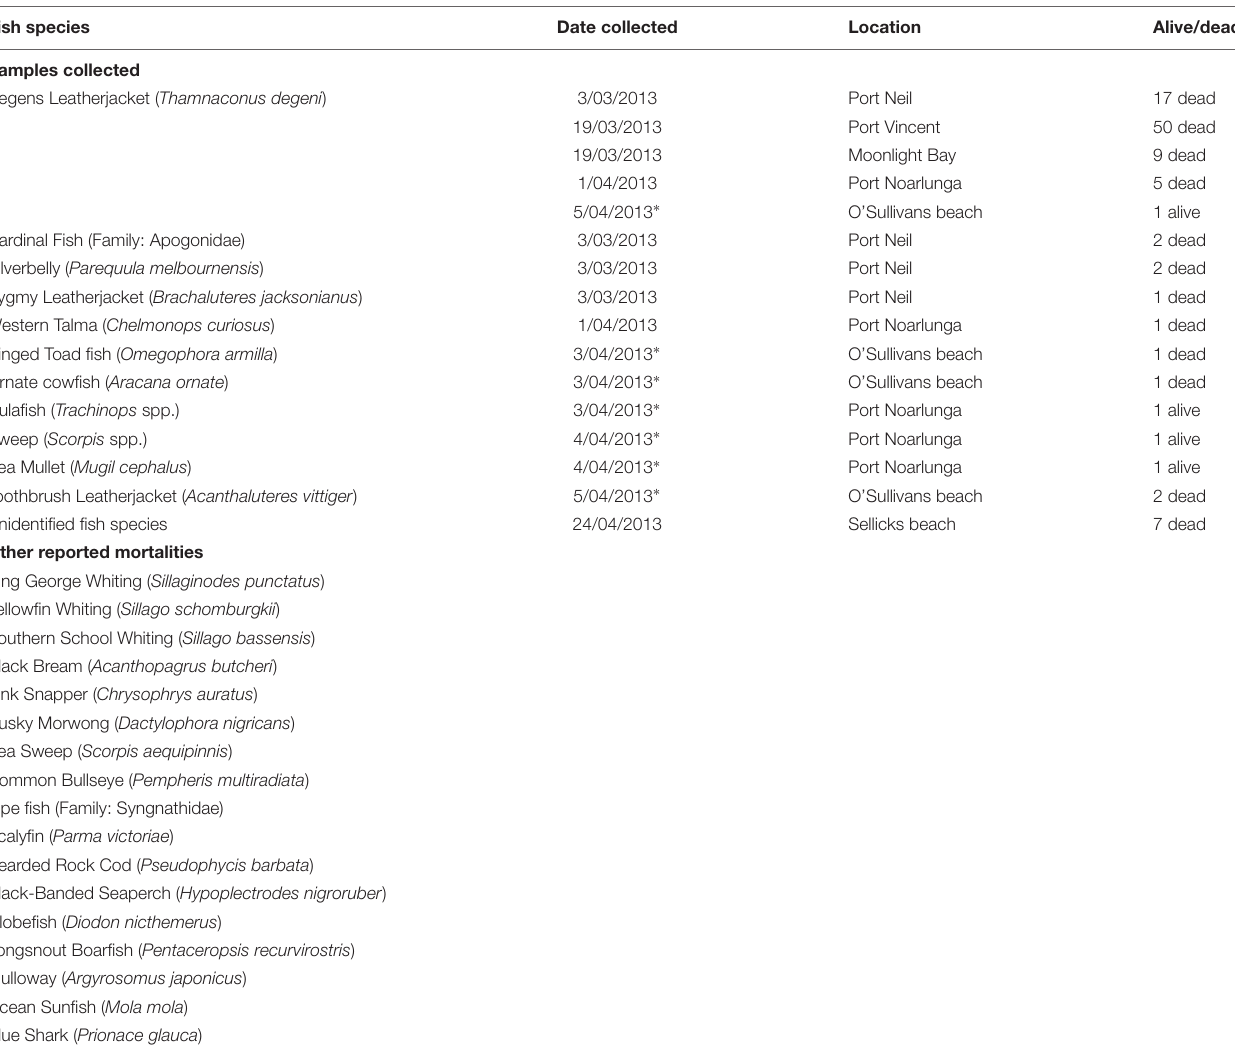
TABLE 3 | Fish samples collected and submitted to the laboratory and other reported fish mortalities during the 2013 fish kill